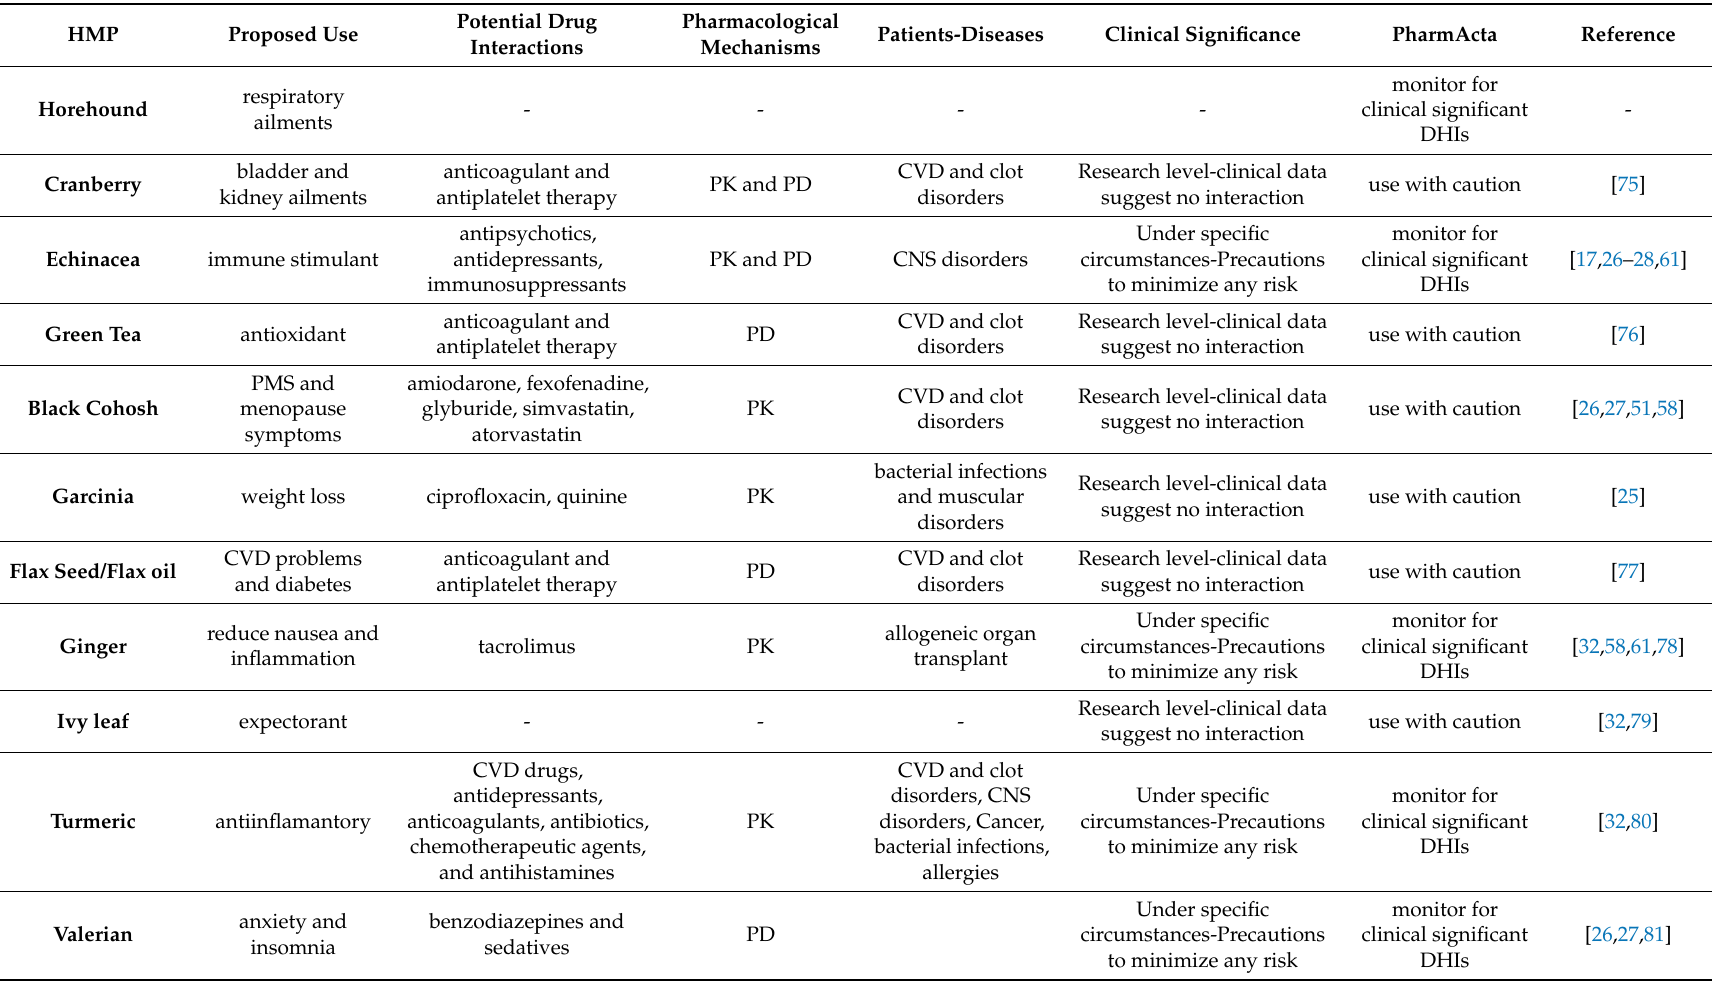
Table 2. Top selling HMPs and how available data are presented in PharmActa regarding potential drug–herb